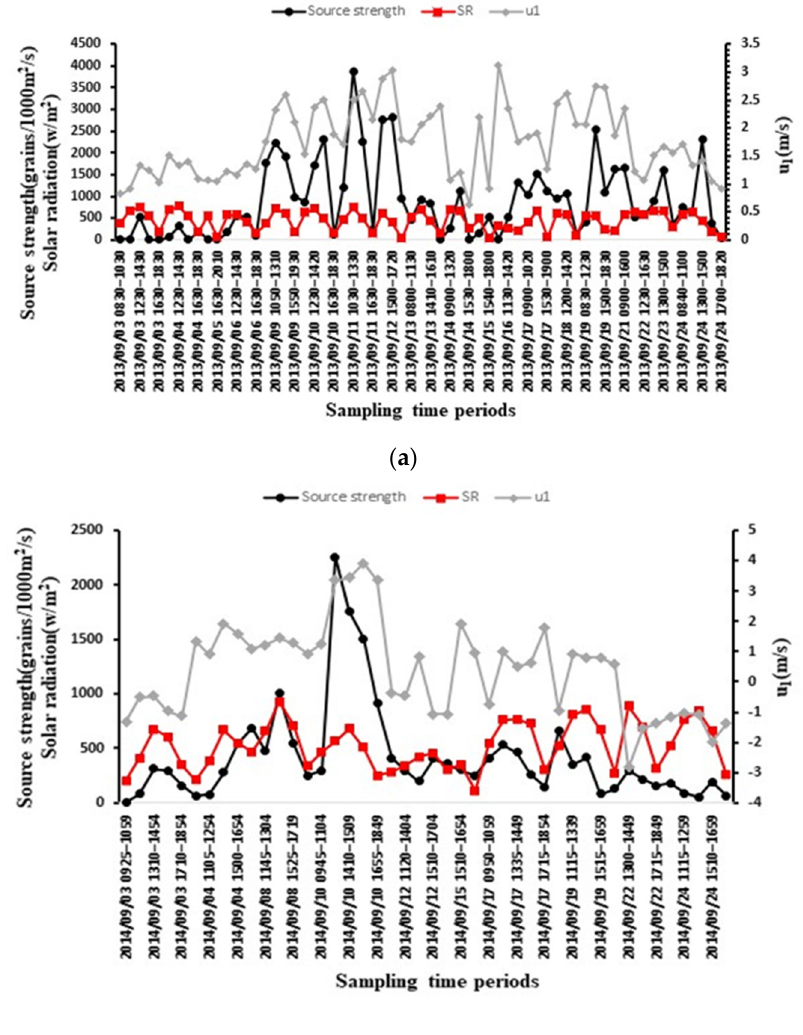
Figure 10. Hourly seed source strength (Q 0 , black line), solar radiation (SR, red line), and the mean wind speed (u1, grey line) from 3 September to 24 September for ( a ) Illinois source field; ( b ) Tennessee source field.